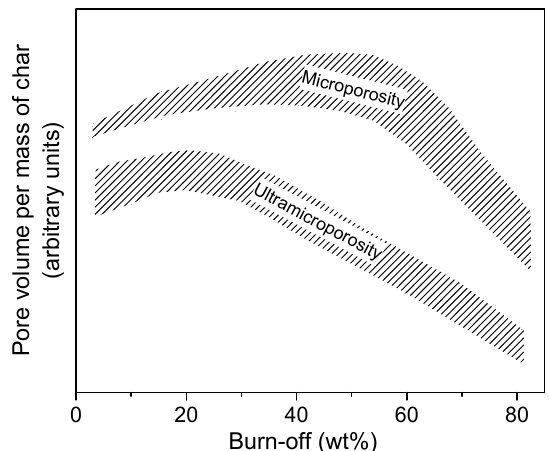
Figure 6. Typical variation of microporosity ( < 2 nm) and ultramicroporosity ( < 0.7 nm), expressed per unit weight of char, as a function of burn-off in physical activation.